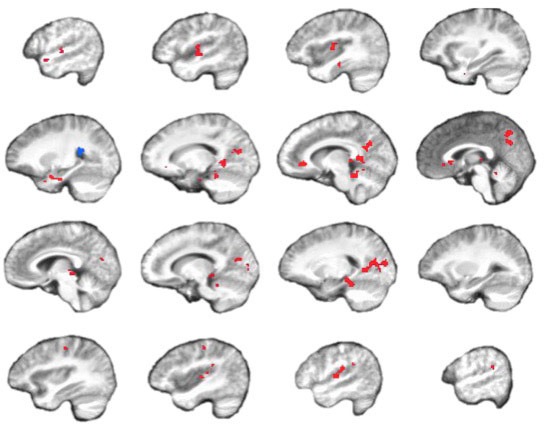
Selective effects of stimulation on memory-specific connectivity.All regions showing a significant interaction between condition and demand following PMN-targeted stimulation. Red coloration indicates supra-threshold voxels with positive differences (retrieval stimulation effect > rest stimulation effect) and blue coloration indicates negative differences (rest stimulation effect > retrieval stimulation effect).